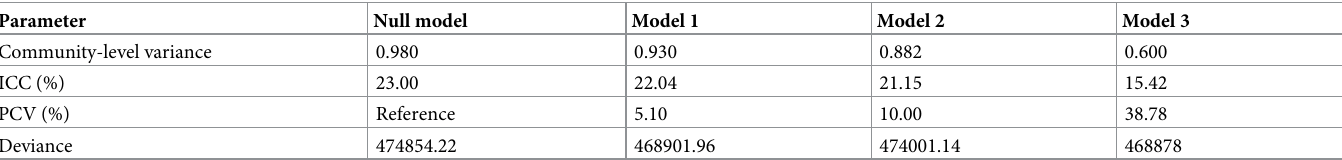
Table 3. Random effect analysis and model comparison in the assessment of factors associated with knowledge about MTCT of HIV/AIDS and its prevention in SSA.